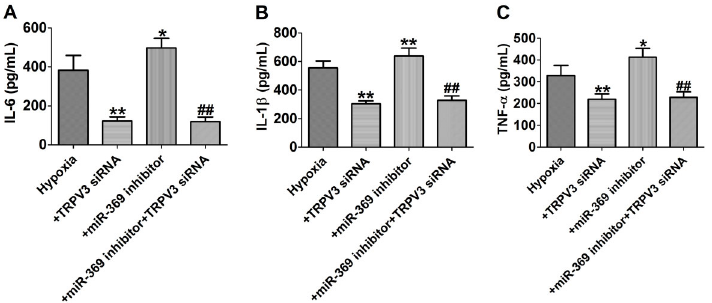
Figure 6. A – C , Concentrations of interleukin (IL)-6, IL-1 b , and tumor necrosis factor (TNF)- a measured by ELISA assay. Data are reported as means ± SE for n=4. *P o 0.05, **P o 0.01 vs hypoxia group; ## P o 0.01 vs hypoxia + miR-369 inhibitor and hypoxia groups